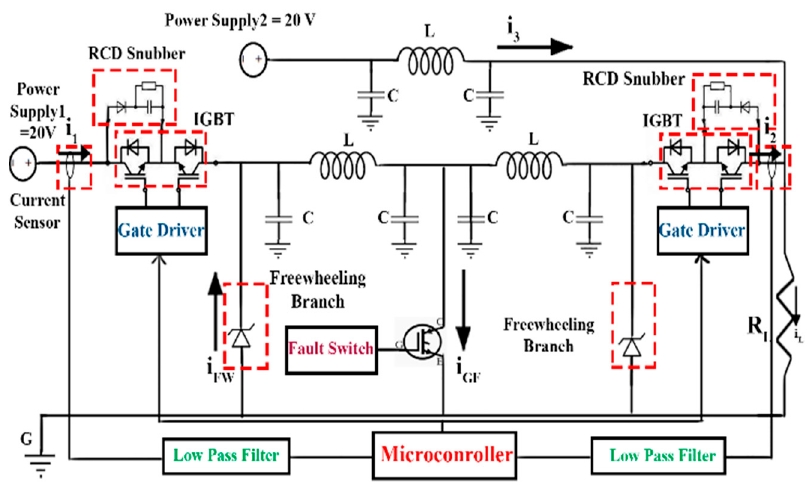
Figure 19. Electrical scheme of the testbed experimental prototype.